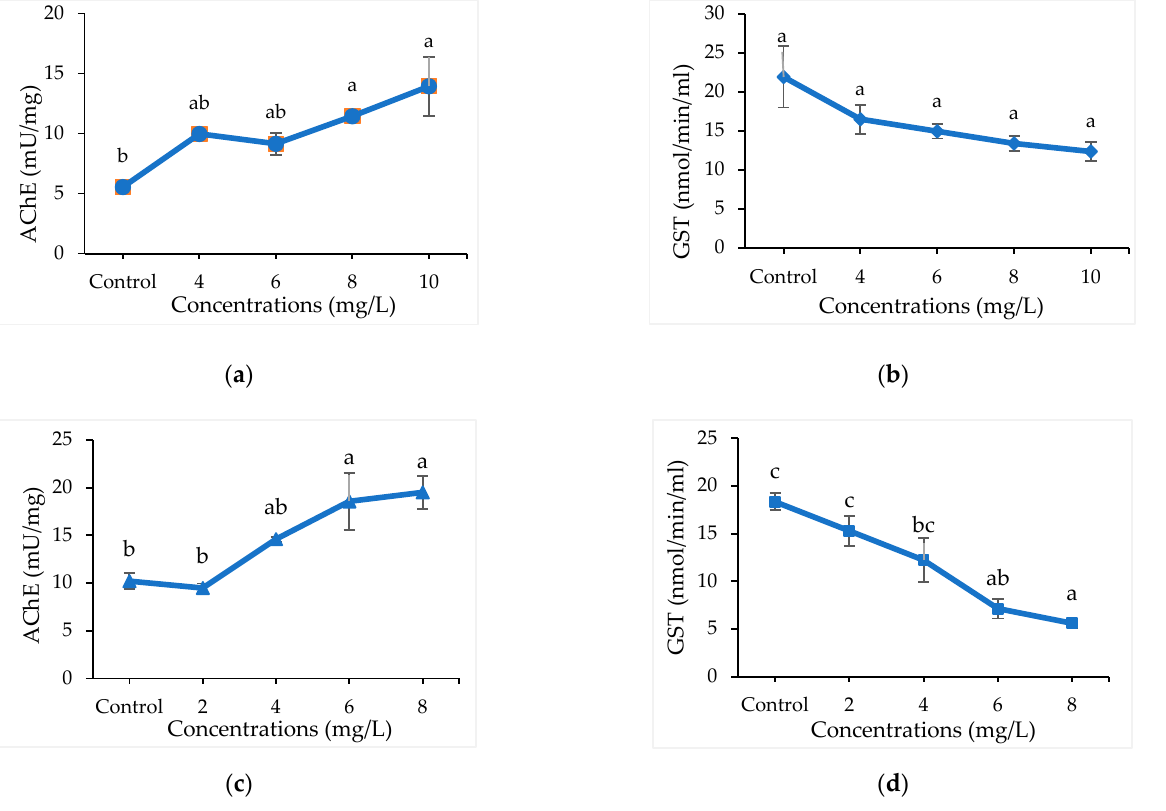
Figure 1. Detoxification enzyme inhibition activities: AChE ( a ) and GST ( b ) in C. chinensis ; AChE ( c ) and GST ( d ) in C. maculatus treated with A. maritima oil; Bars represents a standard error ( ± SE) of three replications; Means followed by the same letters within a figure do not differ significantly by Tukey’s HSD ( p ≤ 0.05)